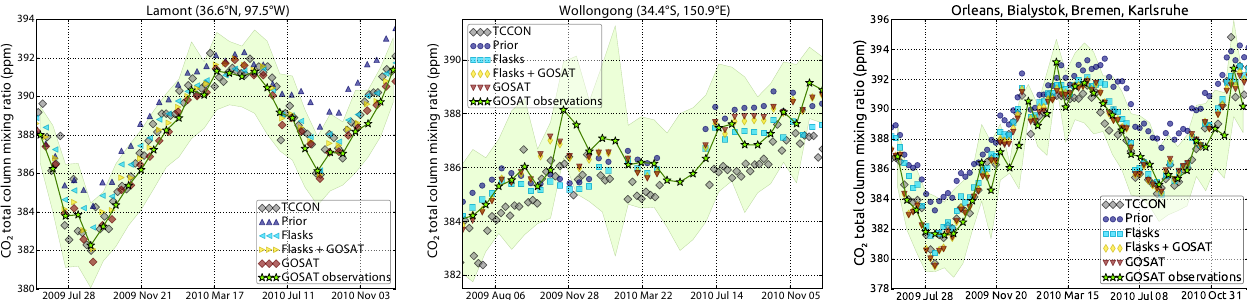
Fig. 6. 7-day averaged TCCON data at Lamont (left) and Wollongong (center), along with posterior CO 2 fields co-sampled and convolved with the respective averaging kernels. For each TCCON station, coincident GOSAT observations have been averaged over 15 days – due to higher scatter – and plotted over. The shaded area is the standard deviation of all the coincident data for a month, i.e., it is the “error bar” region of the stars. Over Europe (right), due to gaps in TCCON data over individual stations, data from four stations have been combined, along with their corresponding coincident GOSAT data and posterior co-sampled X CO . 2